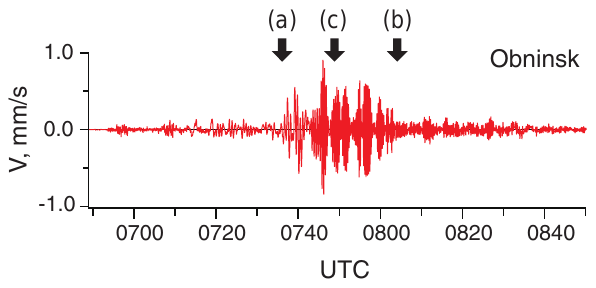
Figure 1. Vertical ground motion of 2010 Chile earthquake ob- served at Obninsk. Arrows (a), (b), and (c) correspond to ionograms shown in Fig. 2. To relate the seismogram to ionograms, times are shifted by 11min, taking account of propagation times of Rayleigh waves from Obninsk to Kazan and acoustic waves from the ground to ionospheric elevations.